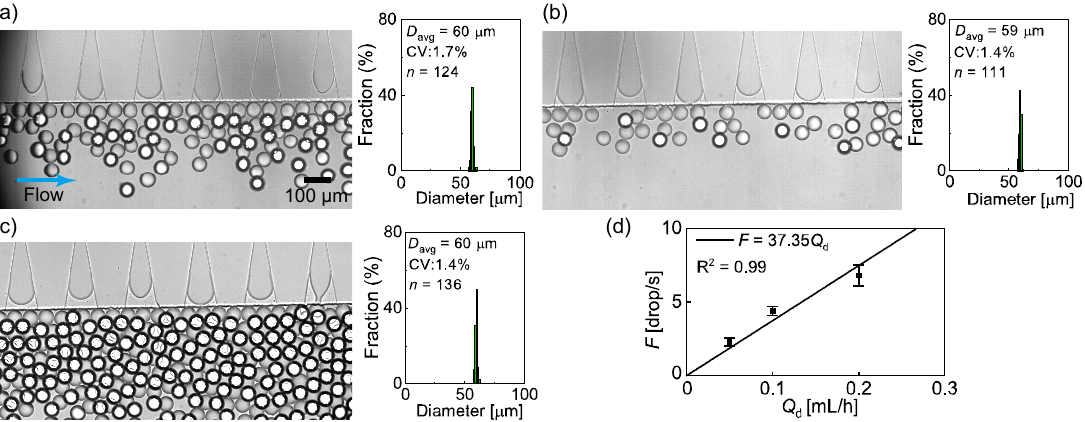
Figure 2. Step emulsification at different flow rates. (a–c) Formation of droplets and their size distributions when the disperse phase flow rate ( Q d ) was set at ( a ) 0.1, ( b ) 0.05, and ( c ) 0.2 mL/h while the continuous phase flow rate was kept at 10.0 mL/h. ( d ) Effect of Q d on the droplet break-off frequency per nozzle ( F